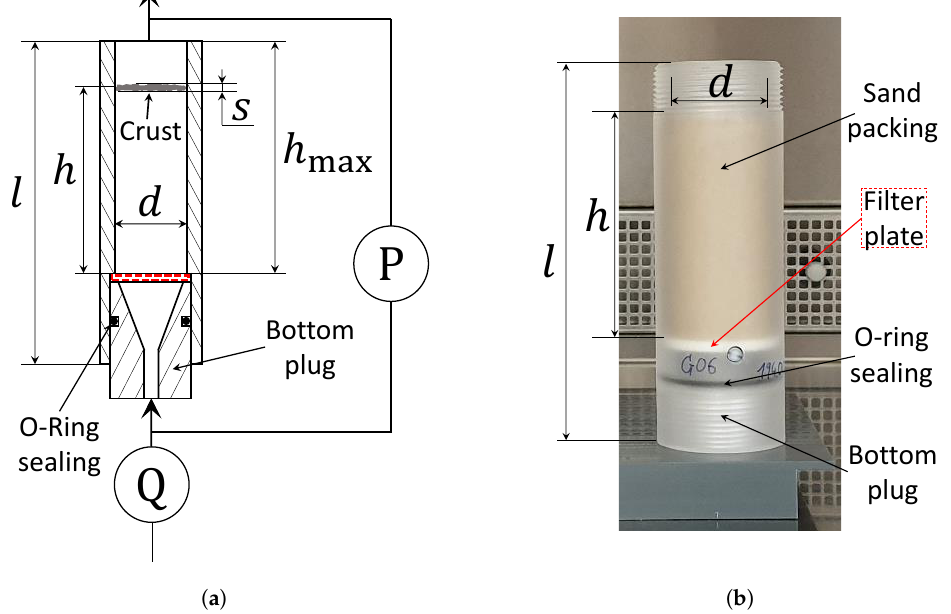
Figure 1. ( a ) Sketch of the gas permeameter set-up with attached crust. The sample holder consisted of PMMA and had an inner diameter d = 31mm, a sample holder length l = 140mm, and a maximum filling height h max = 100mm. The sample height h = 80mm denotes the initial filling height of the sample. After crust formation, the sand below the crust was removed and dry nitrogen was flown through the crust with thickness s using four different flow rates controlled by the flow controller Q. A pressure transducer P monitored the pressure difference ∆ p over the crust. The red dotted line indicates the position of the filter plate during evaporation, which was fixed with the removable bottom plug and was removed for the gas flow measurements. ( b ) Photo of the sample holder filled with sand and